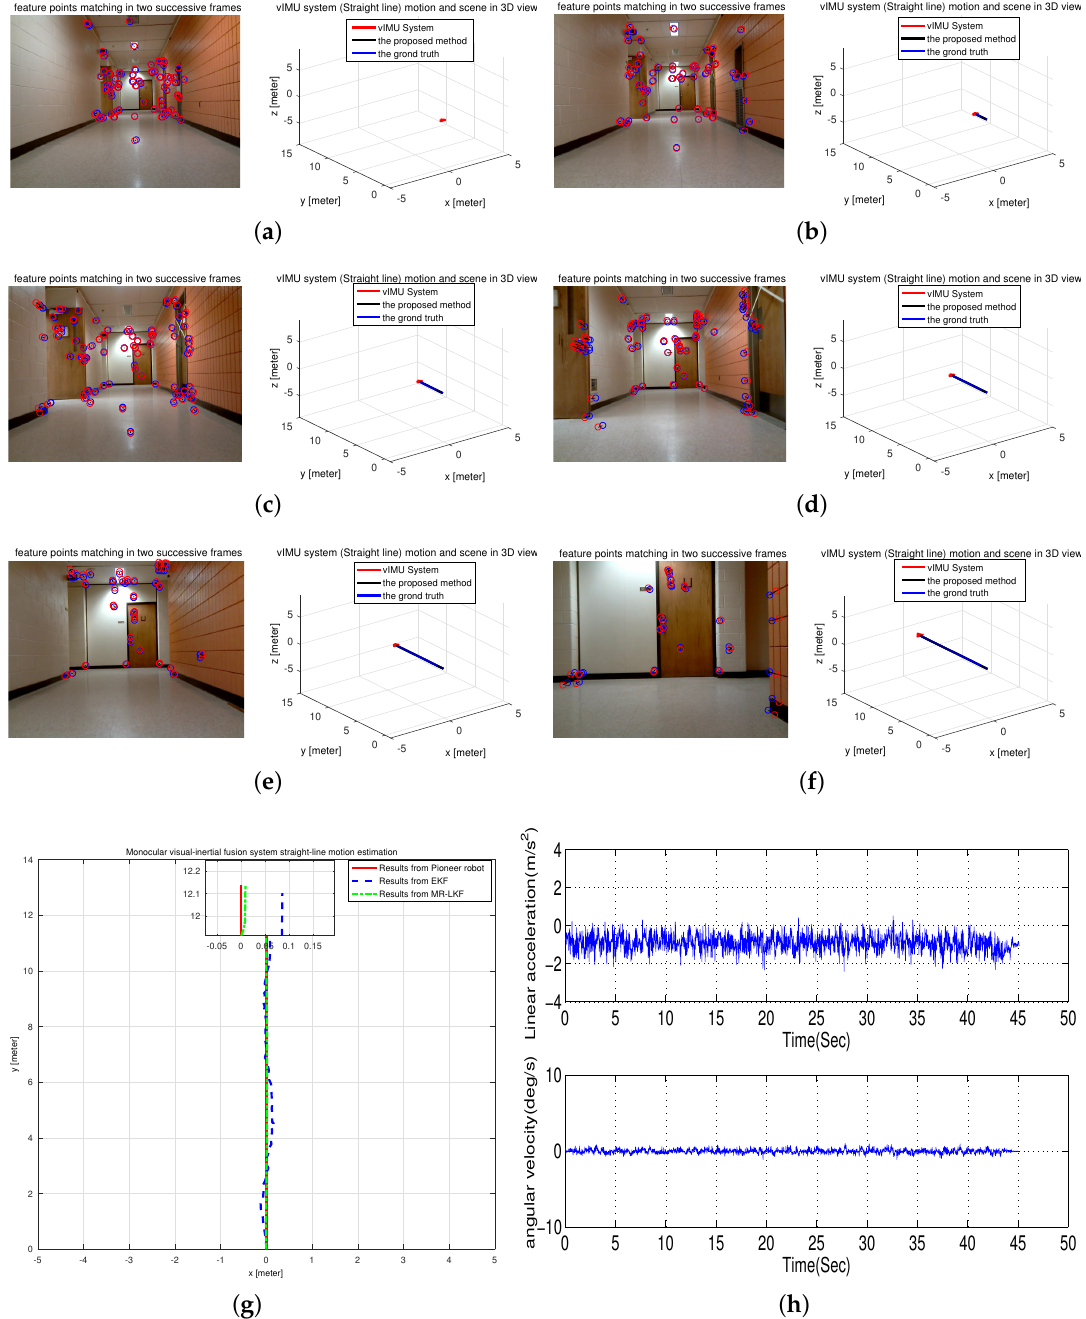
Figure 10. Straight-line Motion Estimation in a hallway. ( a – f ) typical frames; ( g ) estimated trajectory with a magnified final position; ( h ) inertial